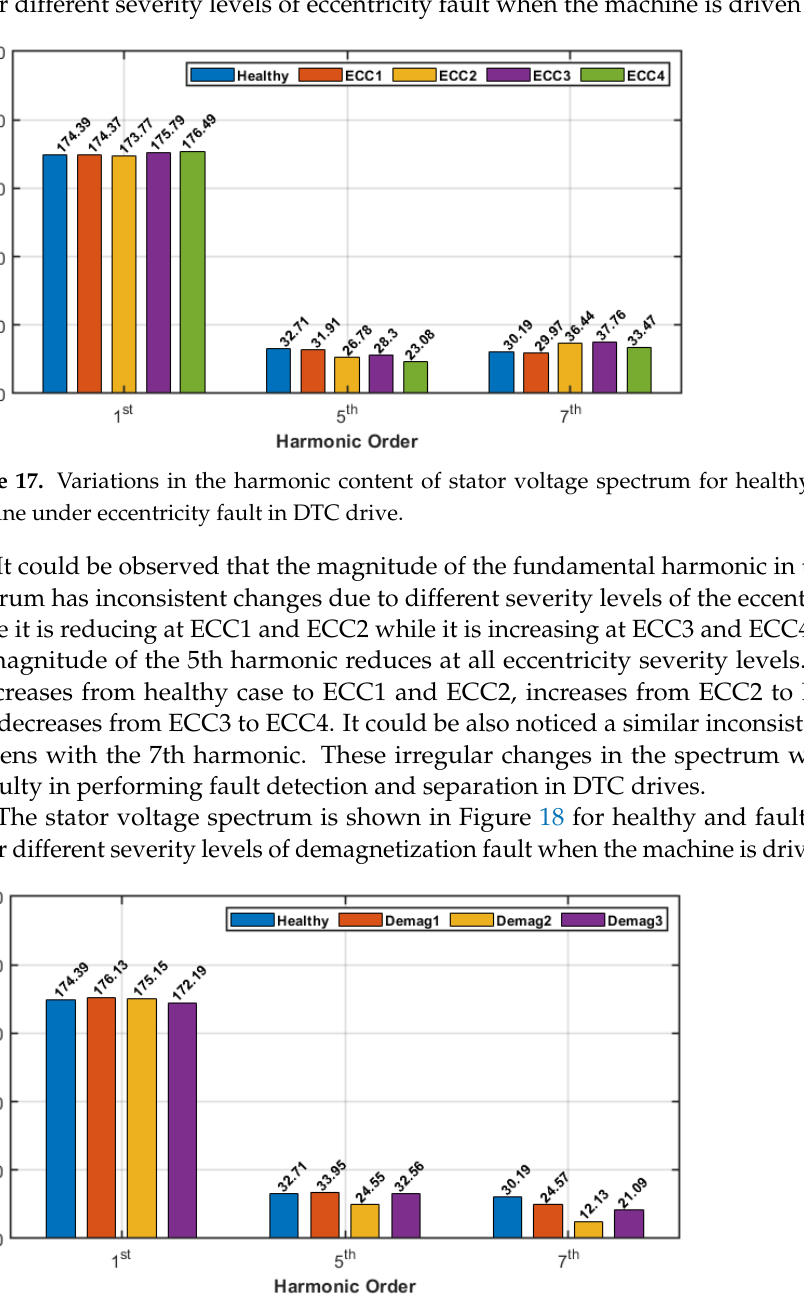
Figure 18. Variations in the harmonic content of stator voltage spectrum for healthy and faulty machine under demagnetization fault in DTC